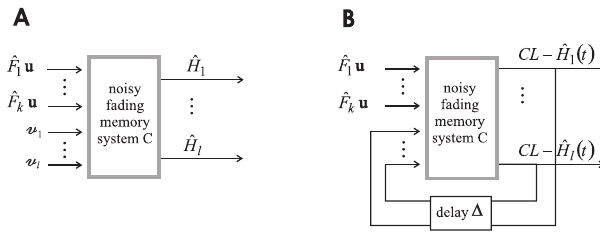
Figure 6. Emulation of an FSM by a Noisy Fading-Memory System with Feedback According to Theorem 5 (A) Underlying open-loop system with noisy pattern detectors Fˆ 1 , ... , Fˆ k and suitable fading-memory readouts Hˆ 1 , ... , Hˆ l (which may also be subject to noise). (B) Resulting noise-robust emulation of an arbitrary given FSM by adding feedback to the system in (A). The same readouts as in (A) (denoted CL (cid:2) Hˆ j ( t ) in the closed loop) now encode the current state of the simulated